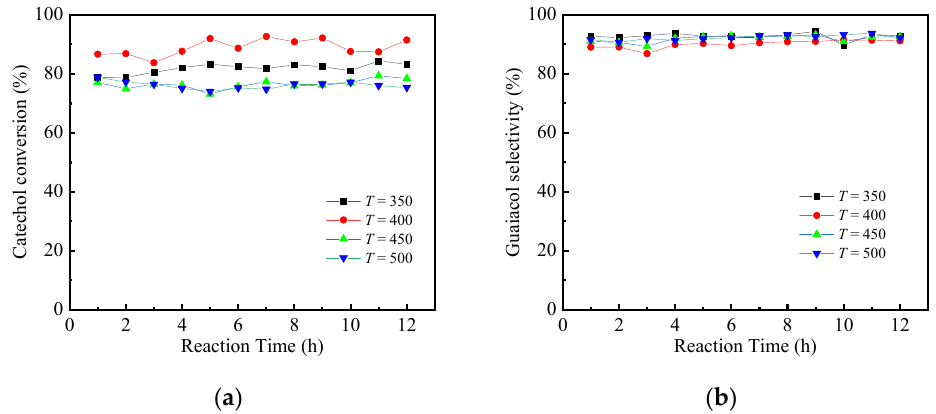
Figure 7. Catalytic performance of AlP 1.1 Zr 0.012 - T catalysts. ( a ) catechol conversion; ( b ) guaiacol se- lectivity. Reaction condition: m cat = 2 g, Reaction temperature = 553 K, LHSV = 0.2 h − 1 , methanol/cat- echol = 5 (mol).